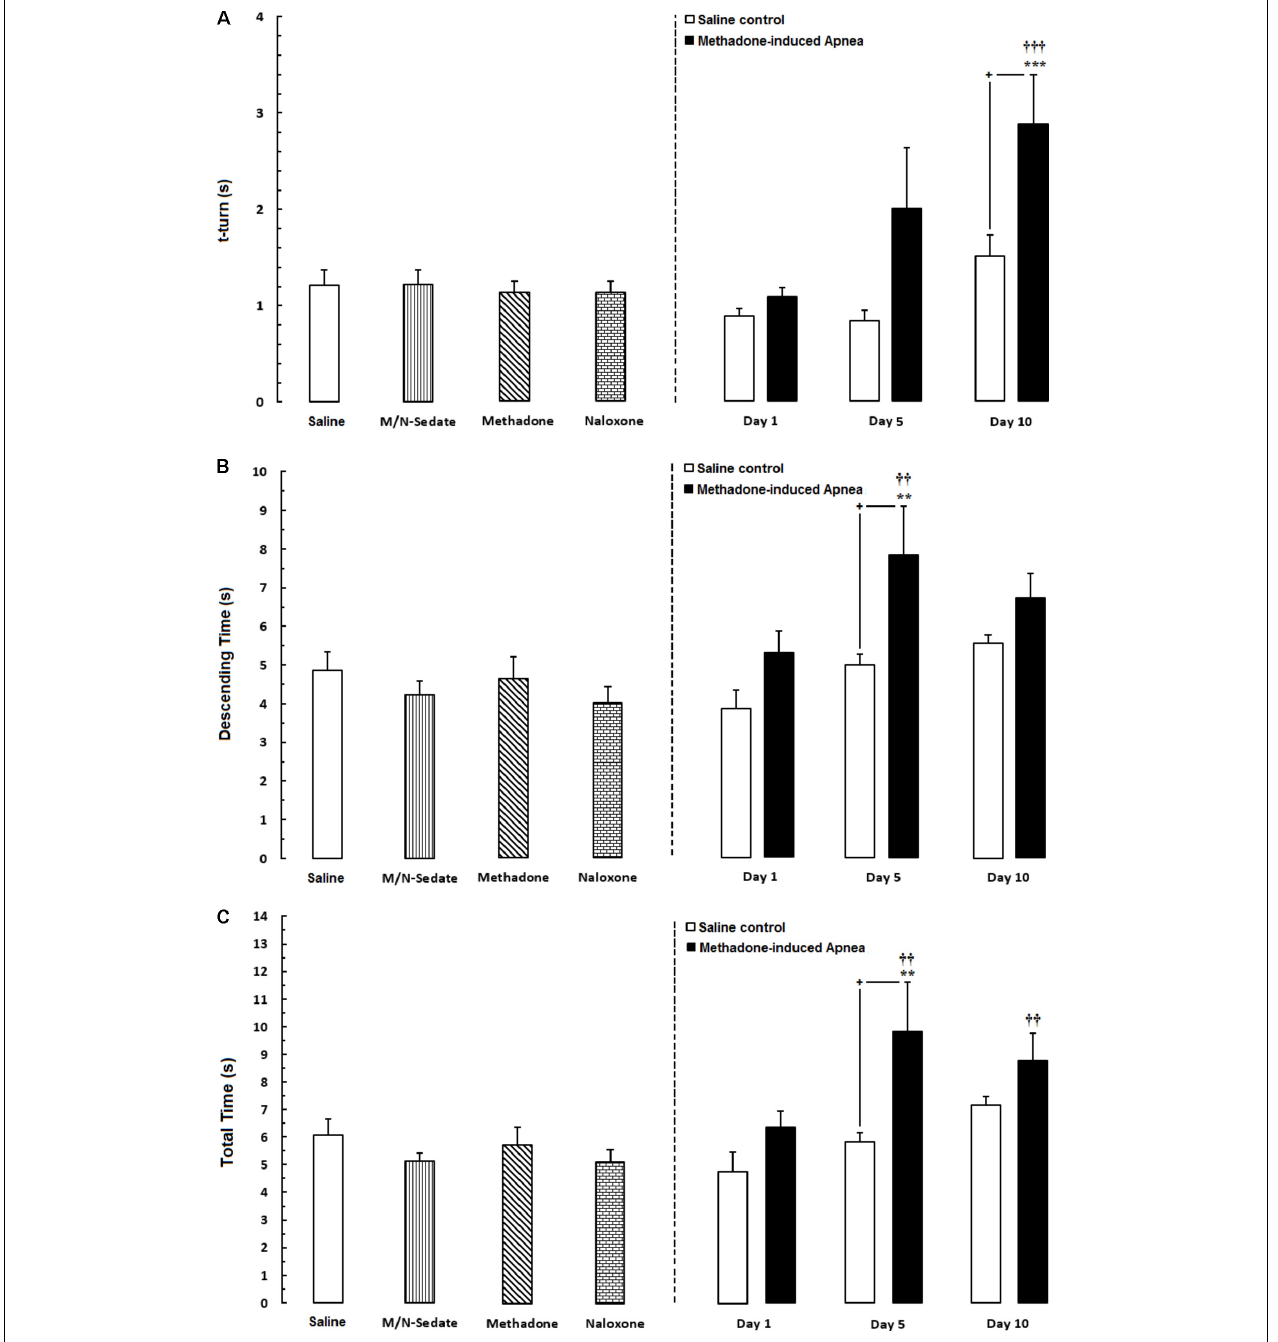
FIGURE 4 | Evaluation of motor performance in pole test such that three parameters were measured including; (A) time to turn downward (t-turn), (B) descending time (time to move downward to reach the floor and (C) total time (time to turn and descending the pole to reach the floor) in different groups, including; M/N-treated groups (a single dose of naloxone was administered after methadone overdose in apnea stage, in animals which experienced apnea and motor behavior was evaluated either on day 1, 5, or 10 day post-resuscitation; M/N-Day 1 ( n = 11), M/N-Day 5 ( n = 6) and M/N-Day 10 ( n = 7) groups and their respective Saline control groups; n = 6; right panel), M/N-Sedate; n = 9 (a single dose of naloxone was administered following methadone overdose, immediately in the initial stage of sedation, so behavioral evaluation was carried out only 1 day after drug administration), Saline; n = 14, methadone; n = 8 and naloxone; n = 8 (saline, methadone or naloxone were administered alone in separated groups in which motor function was evaluated 1 day after drug administration during pole test in adolescent rats) groups. Animals received methadone (15 mg/kg; i.p.) or naloxone (2 mg/kg; i.p.) alone or both in a single dose. Each bar shows the mean ± SEM for 6-14. ∗∗ P < 0.01 and ∗∗∗ P < 0.001 different from the Saline group. †† P < 0.01 and ††† P < 0.001 different from the M/N-Sedate group. + P < 0.05 different from their respective Saline control groups.